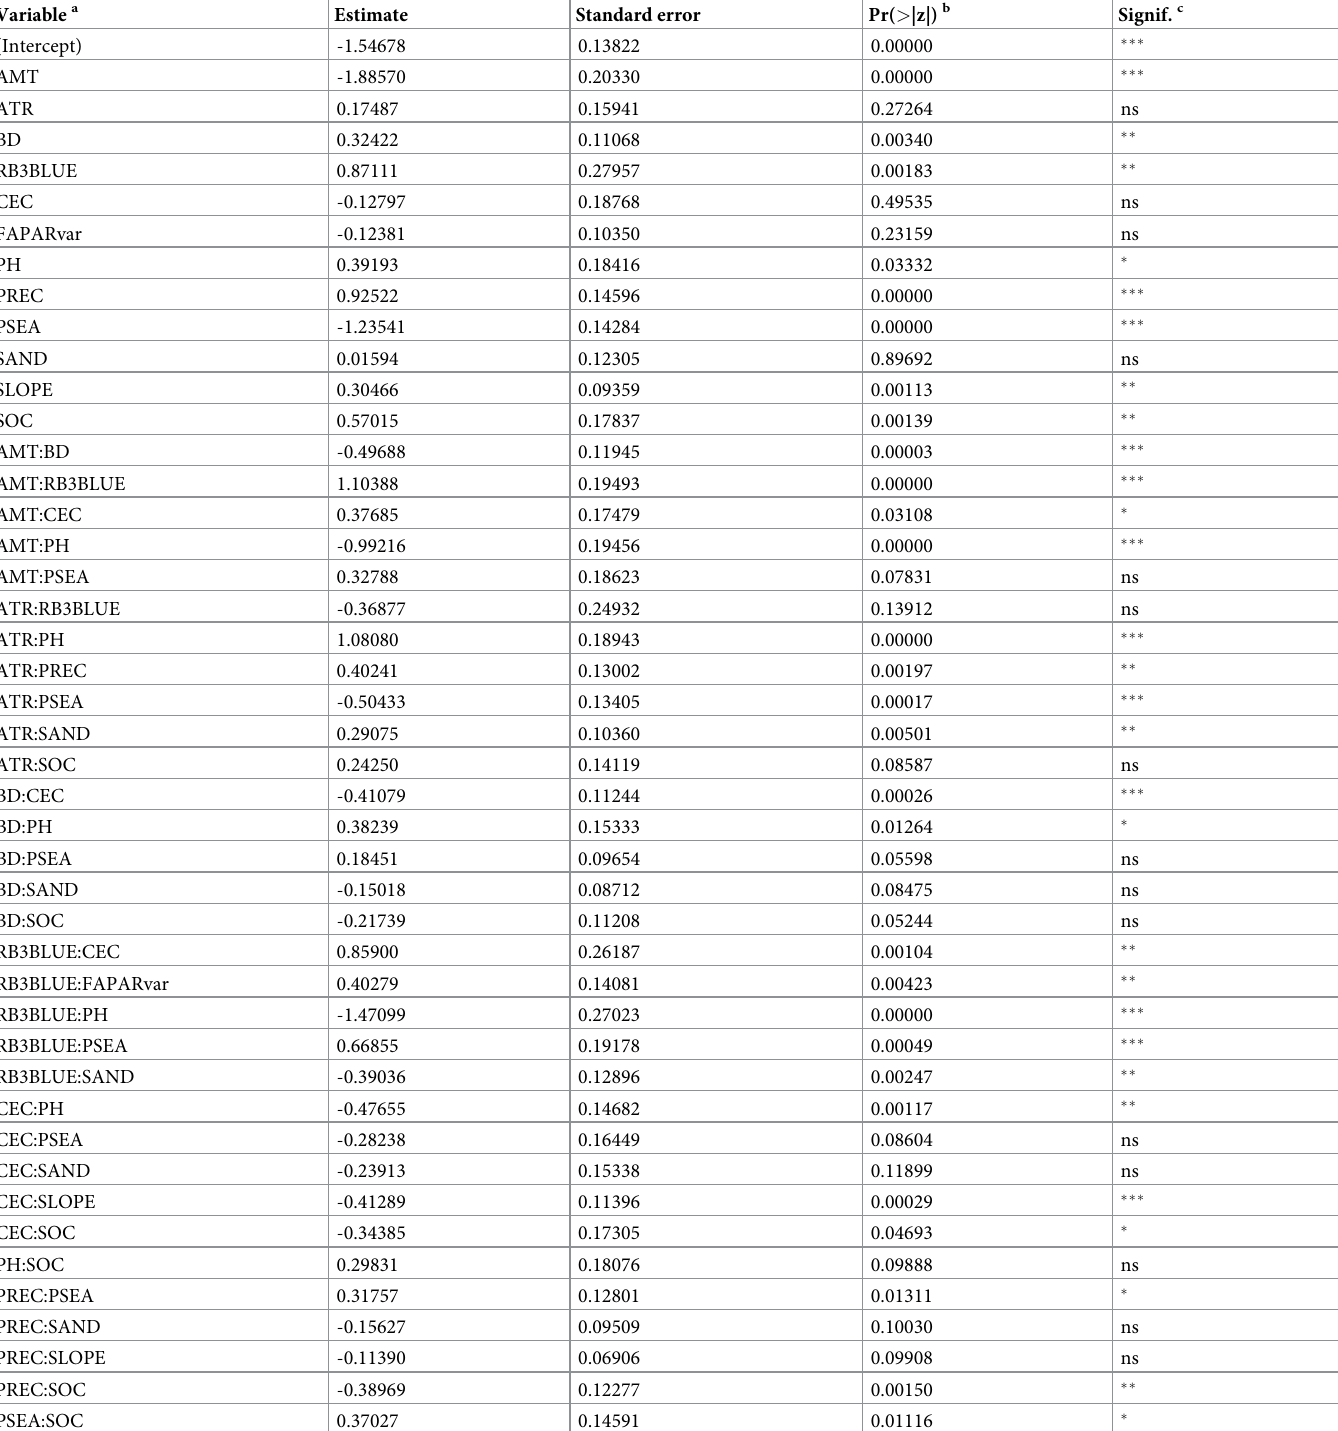
Table 5. Summary results of the logistic regression model M2-12 including the significant two-way interactions to maximise